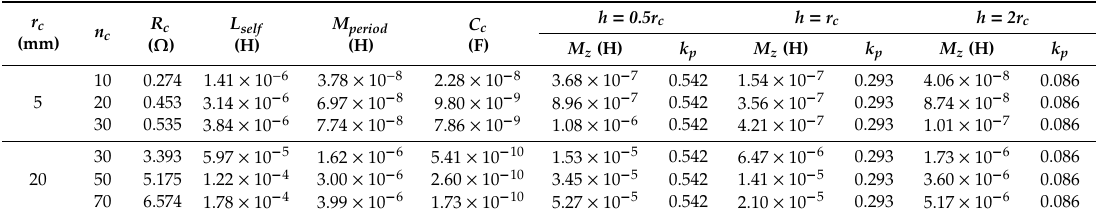
Table 2. Lumped parameters of the electrical circuit.